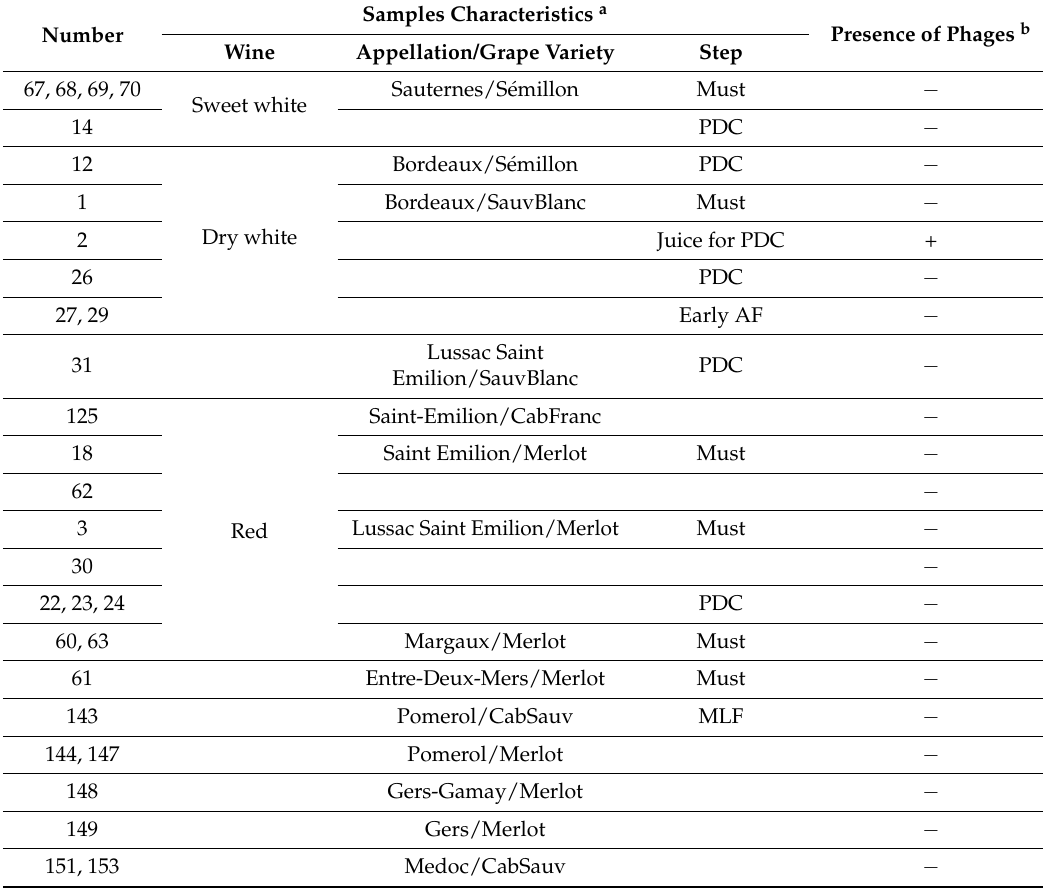
Table 2. Global survey of phages infecting AAB in 30 samples of oenological